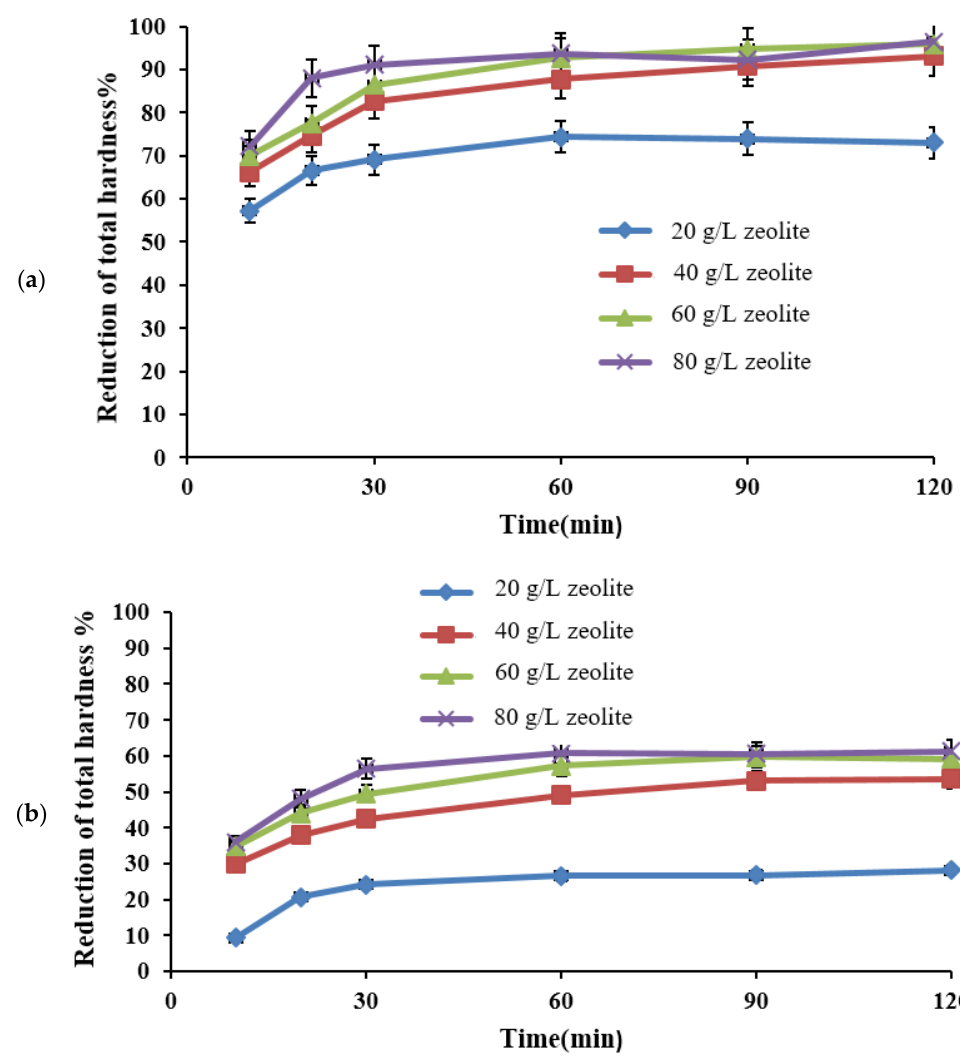
Figure 4. The effect of contact time on the reduction in total hardness (%) of ( a ) drinking water and ( b ) groundwater by natural zeolite.